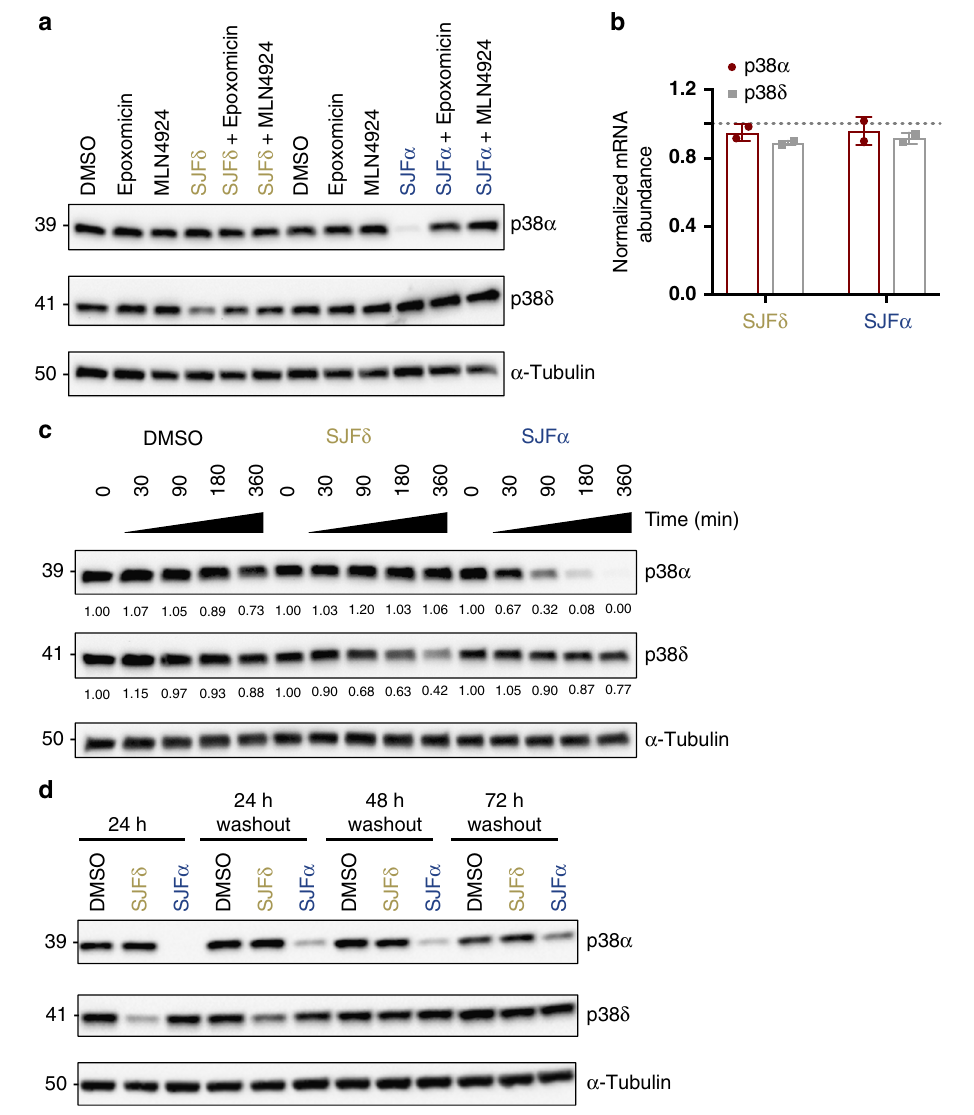
Fig. 2 SJF α and SJF δ degradation of p38 isoforms is rapid, sustained, and proteasome dependent. a MDA-MB-231 cells were either pre-treated or not with the proteasome inhibitor epoxomicin (1 µ M) or the neddylation inhibitor MLN4924 (1 µ M) for 30 min and subsequently treated with either vehicle (DMSO), SJF α (250 nM), or SJF δ (250 nM) for 6 h. b Quantitative real-time PCR was performed after 24 h of treatment with either vehicle (DMSO), SJF α (250 nM), or SJF δ (250 nM) in MDA-MB-231 cells. The dotted line represents DMSO-treated conditions standardized to a value of 1.0 and mRNA abundance (per treatment group) is represented as a fold-change relative to that value. Data are based on biological duplicates and are normalized to beta- tubulin. Error bars denote s.d. c Cycloheximide (CHX) chase assay. MDA-MB-231 cells were pre-treated with 100 µ g mL − 1 CHX for 1 h prior to treating for the indicated times with either vehicle (DMSO), SJF α (250 nM), or SJF δ (250 nM). Tubulin-normalized p38 α and p38 δ abundance values are reported beneath individual lanes. d MDA-MB-231 cells were treated with either vehicle (DMSO), SJF α (250 nM), or SJF δ (250 nM) for 24 h before re-plating